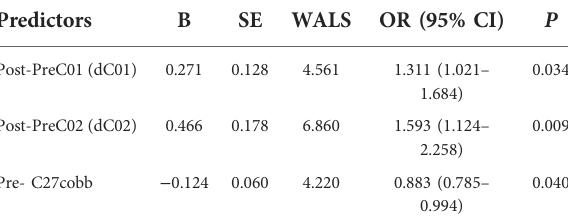
TABLE 4 Logistic regression analysis for the in fl uence of predictors on postoperative dysphagia.